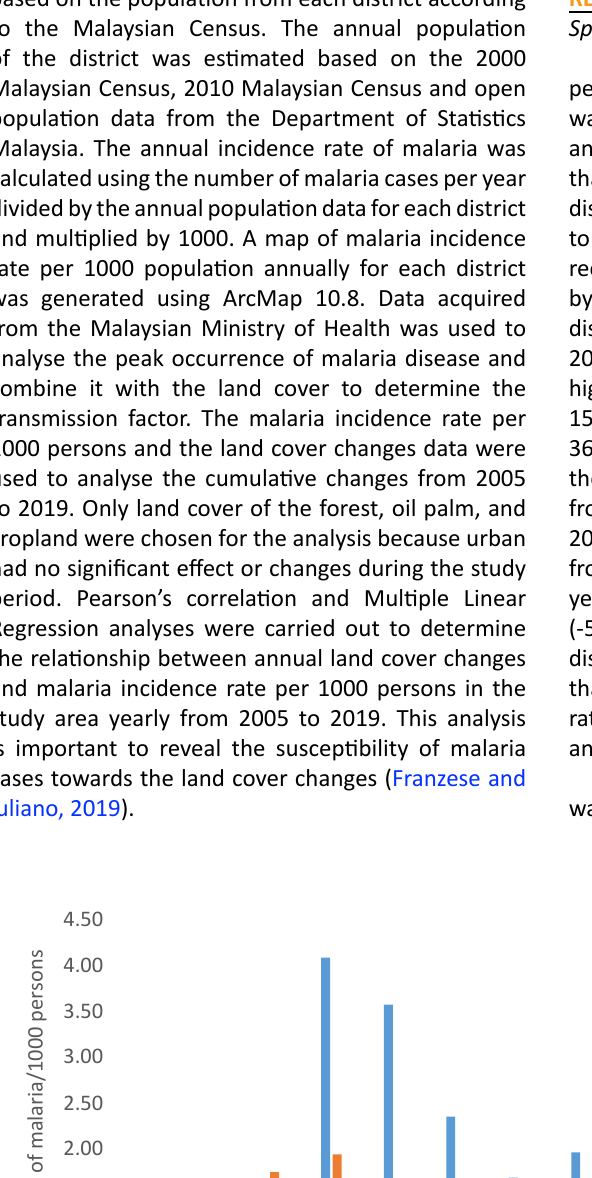
Fig. 2: Malaria incidence rate/1000 persons for highland